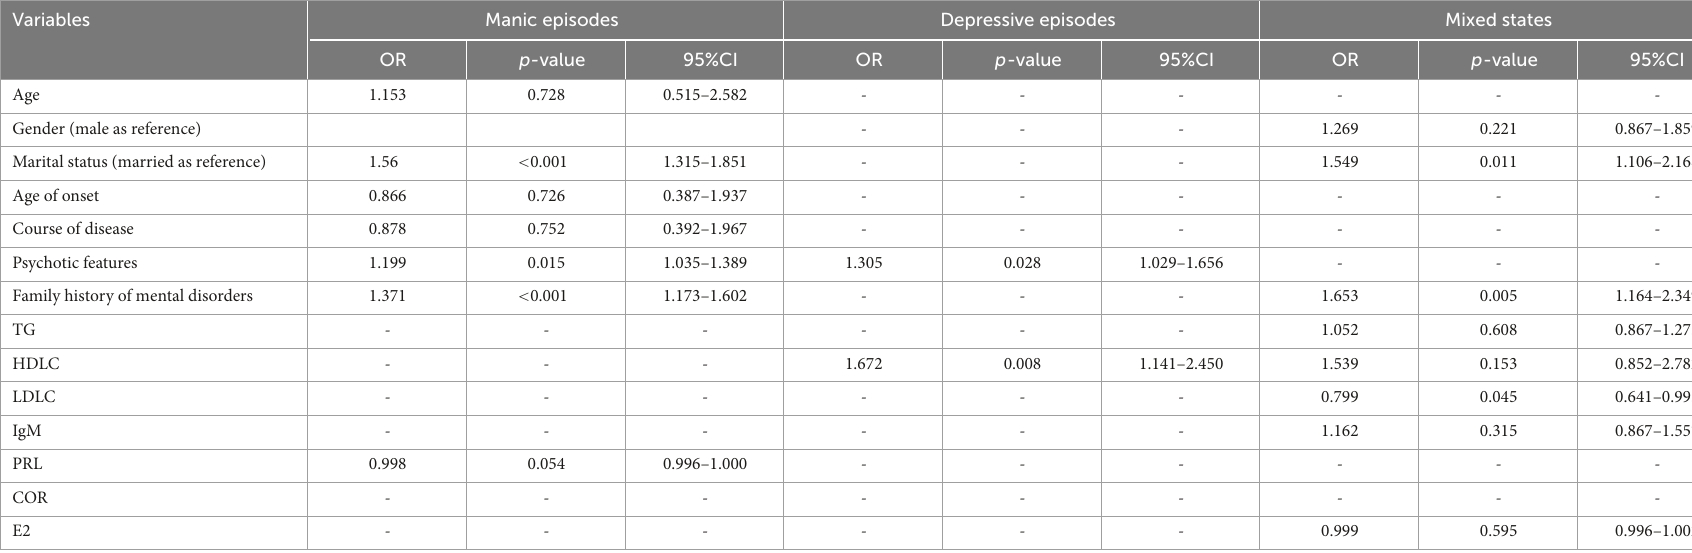
TABLE 4 Multivariable logistic regression analysis of LOS in different